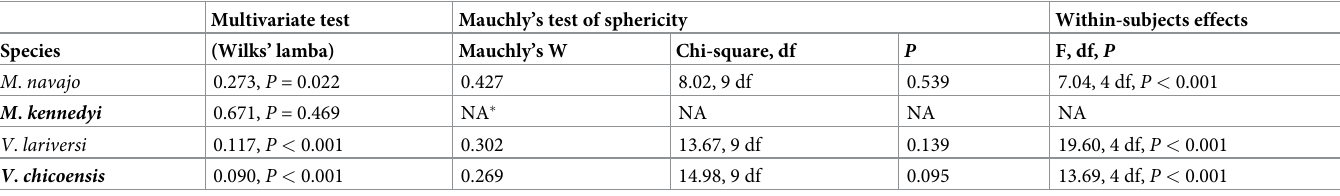
Table 4. Repeated measures ANOVA results for regional variation in facet diameter for one pale (normal font) and one dark species (bold font) (see text) of Myrme- cocystus and Veromessor ( n = 12 per species for Myrmecocystus ; n = 14 per species for Veromessor